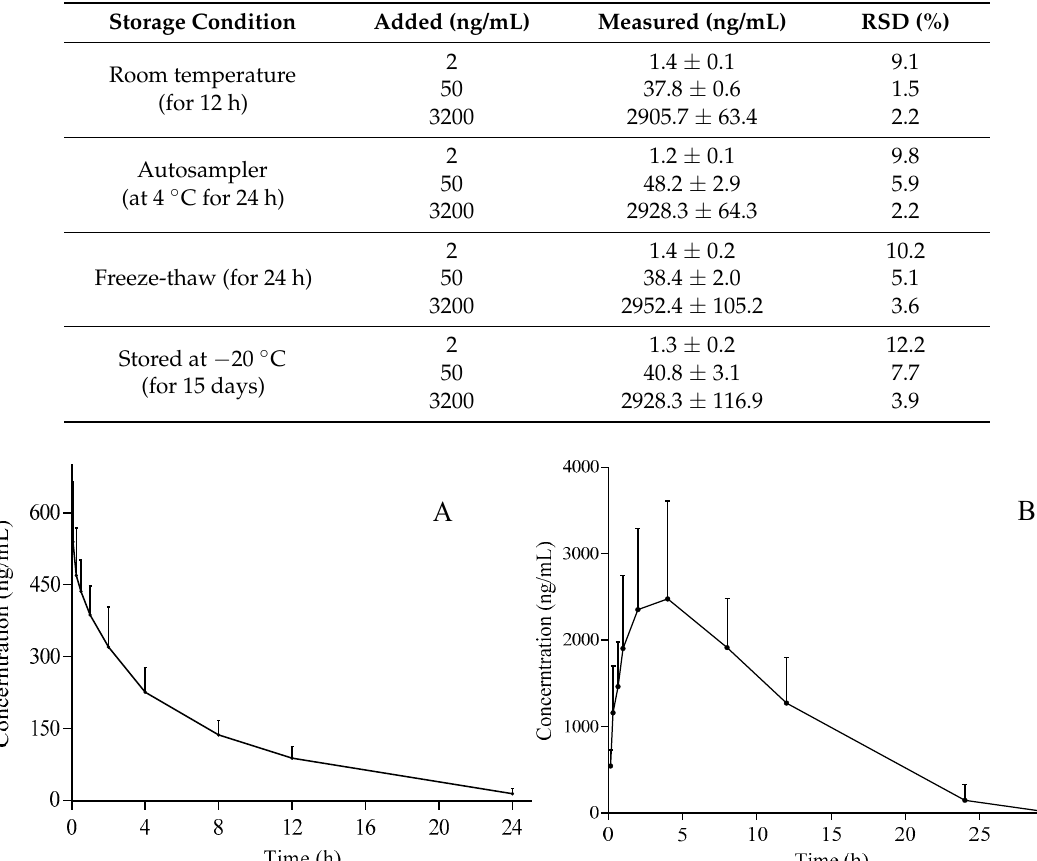
Table 3. Stability of gomisin D in rat plasma (mean ± SD, n = 6).